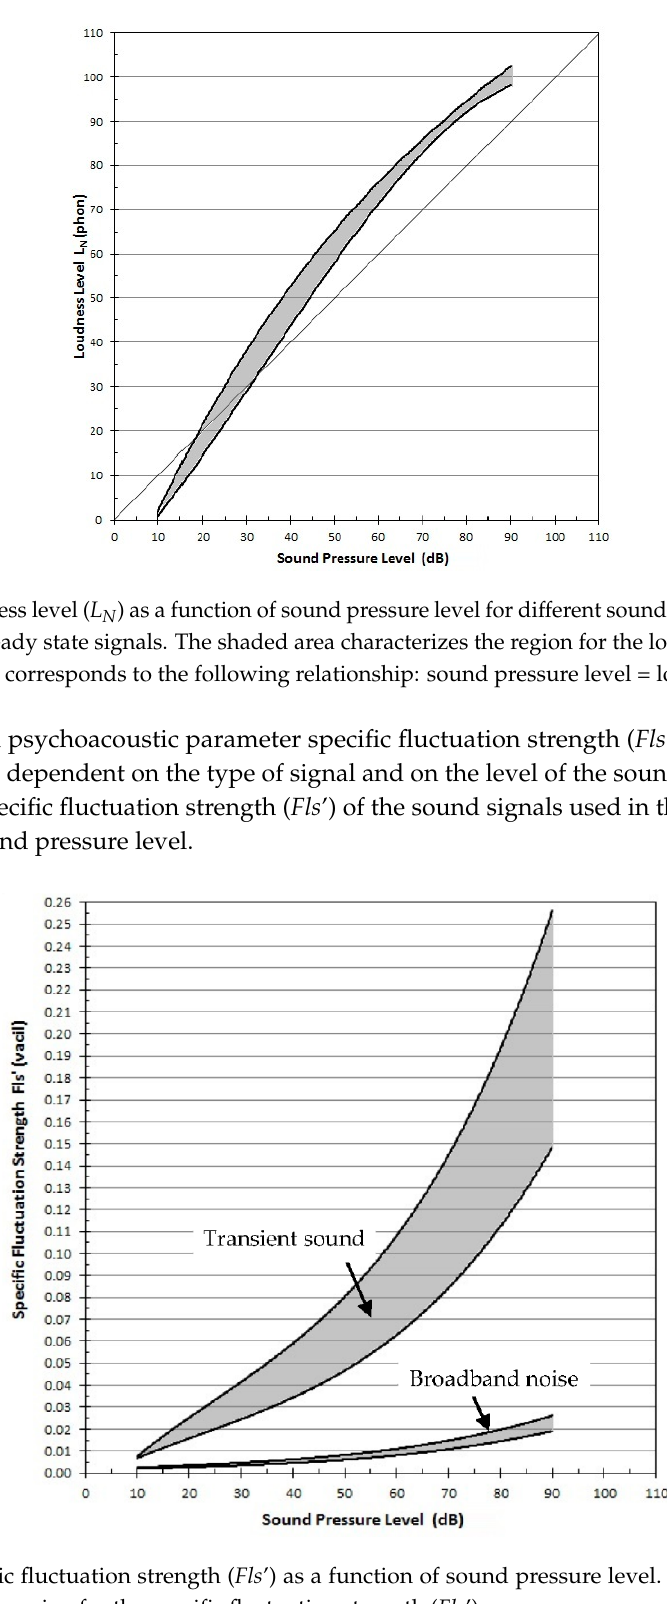
Figure 3. Specific fluctuation strength ( Fls ’) as a function of sound pressure level. The shaded area characterizes the region for the specific fluctuation strength ( Fls